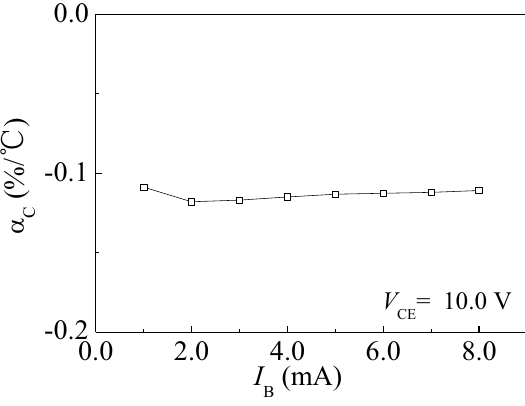
Figure 8. The relationship curve between α C and I B .